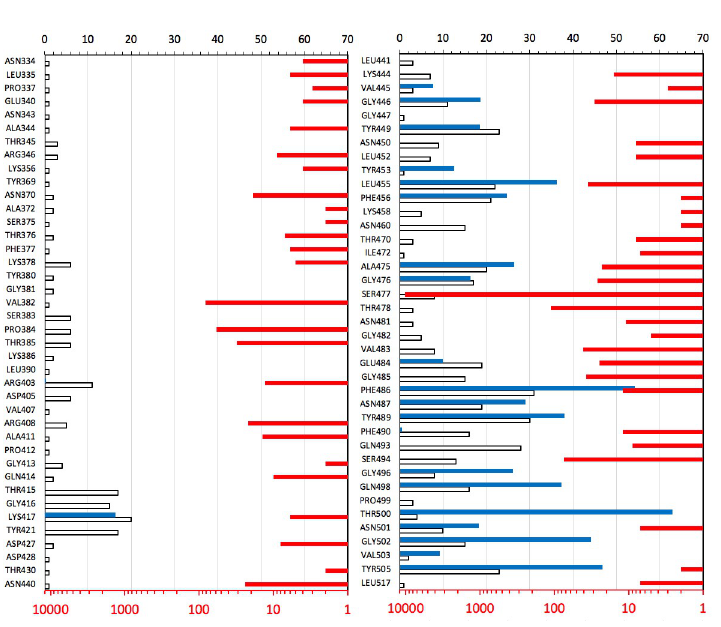
Fig 6. An overview of mutations in structurally characterized epitopes on RBD of SARS-CoV-2 spike protein. The percentages of residue’s area in contact with ACE2 are shown as blue bars. The number of epitopes a residue is involved in is shown as white bars. The prevalence of missense mutations in epitopes is shown as red bars on the opposite (logarithmic) scale. For more details on mutations in currently structurally characterized epitopes, see S2 Fig.